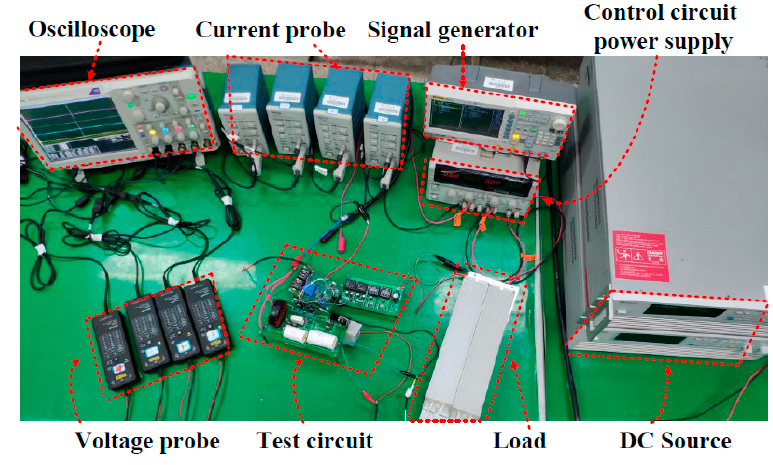
Figure 15. Hardware experimental prototype.